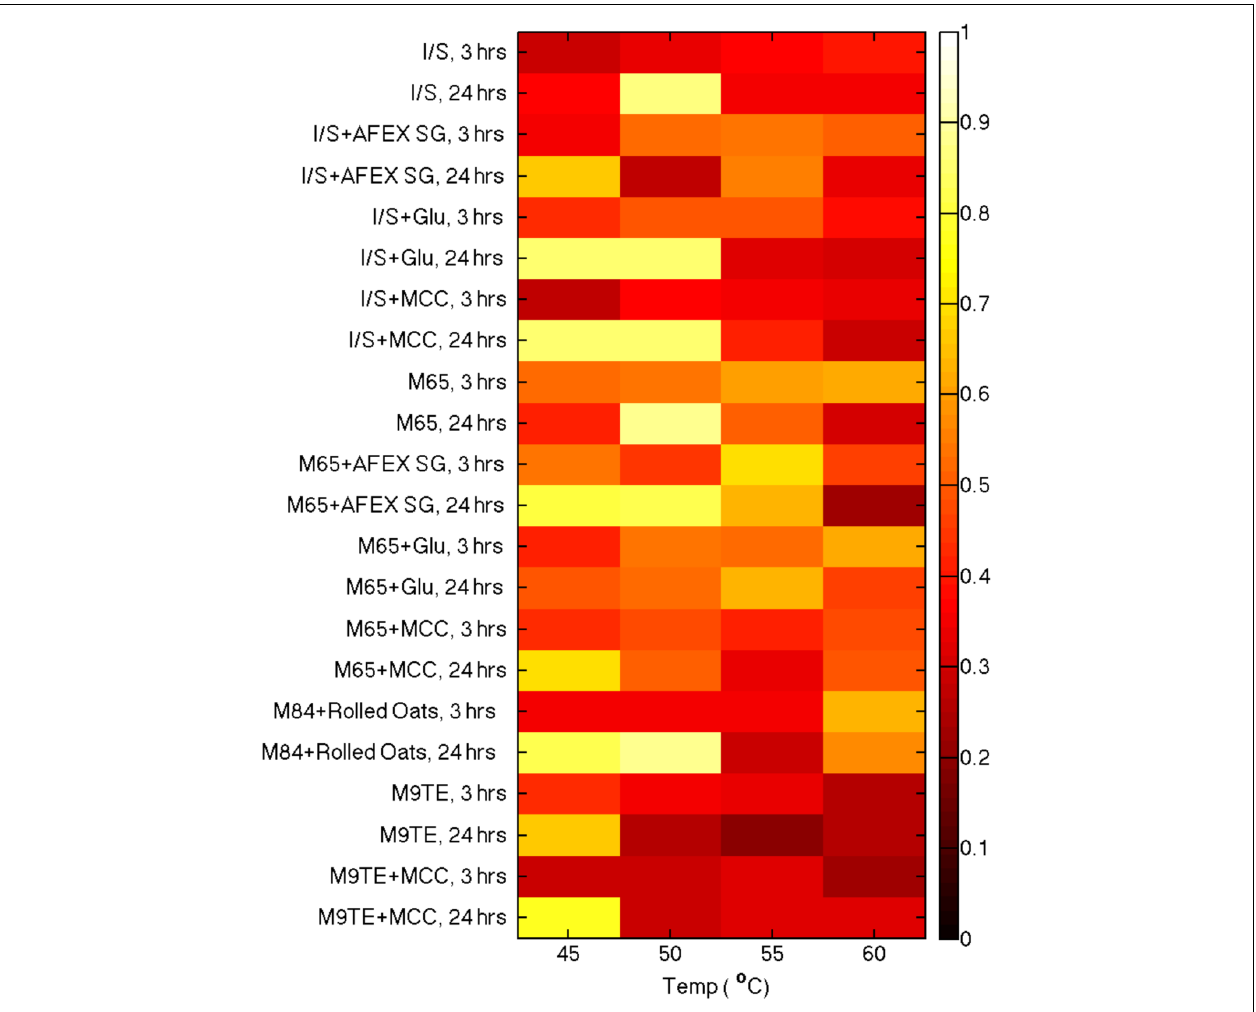
FIGURE 2 |Analysis of β -glucosidase production from cell culture supernatants grown in various media and at different temperatures. Enzyme activities for the various growth conditions were compared using a cellobiose probe incubated at 50 ◦ C for 1 h.